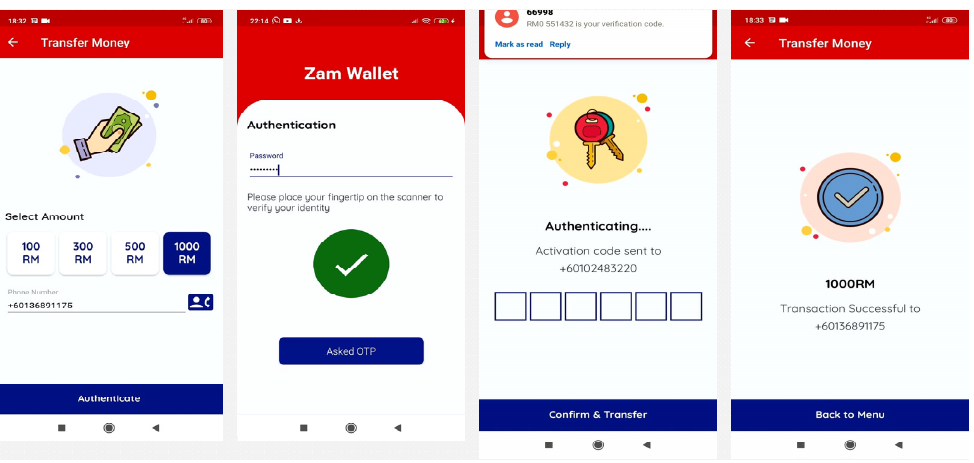
Figure 15. Money transfer activity in Zamwallet.